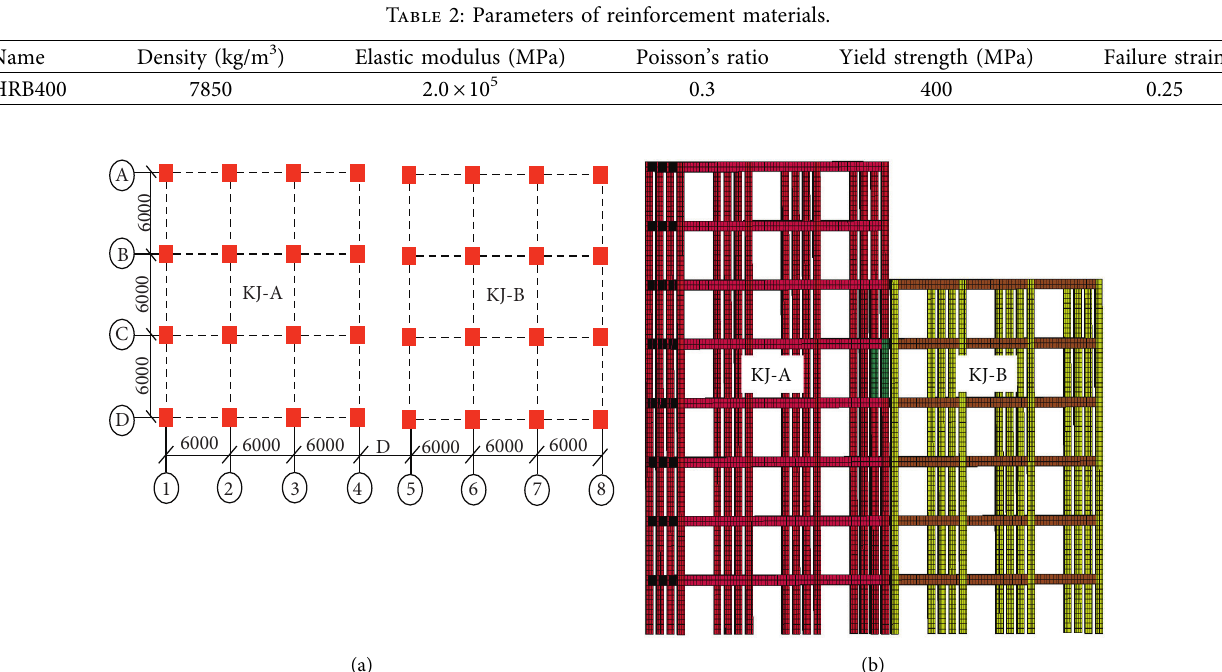
Figure 3: Model information. (a) Plane. (b) Numerical calculation model.